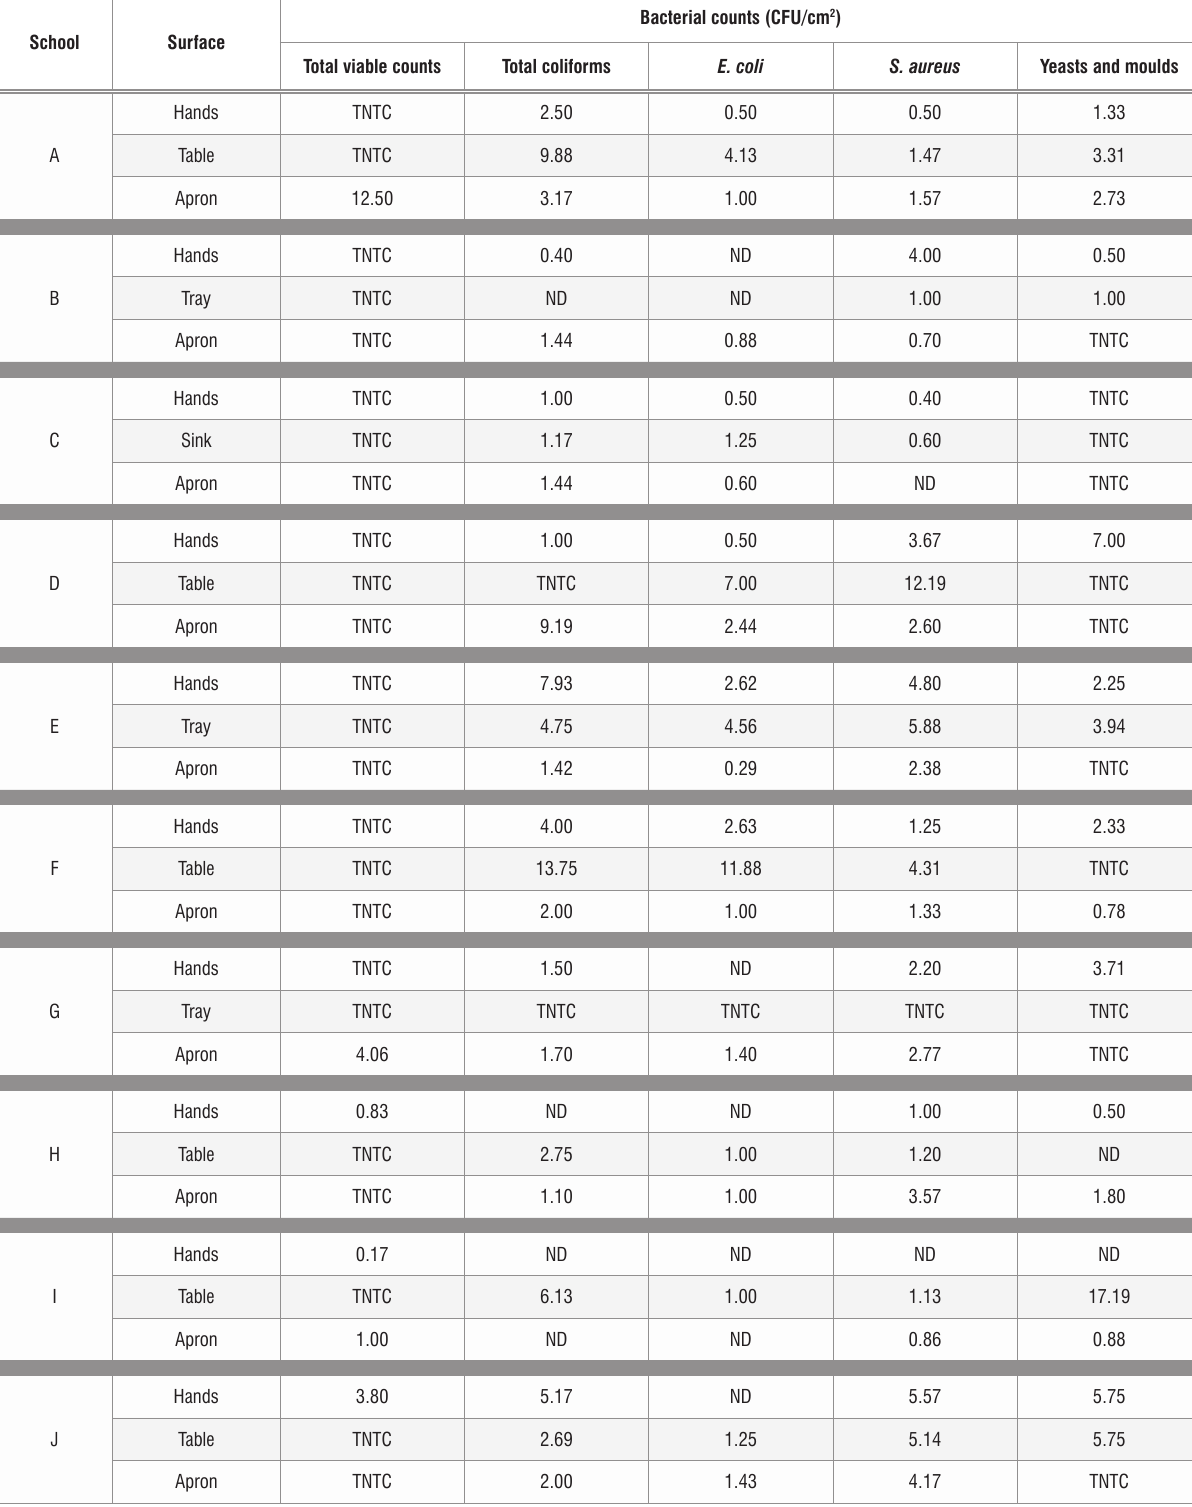
Counts of various organisms from food contact surfaces of schools in Bloemfontein participating in the National School Nutrition Programme